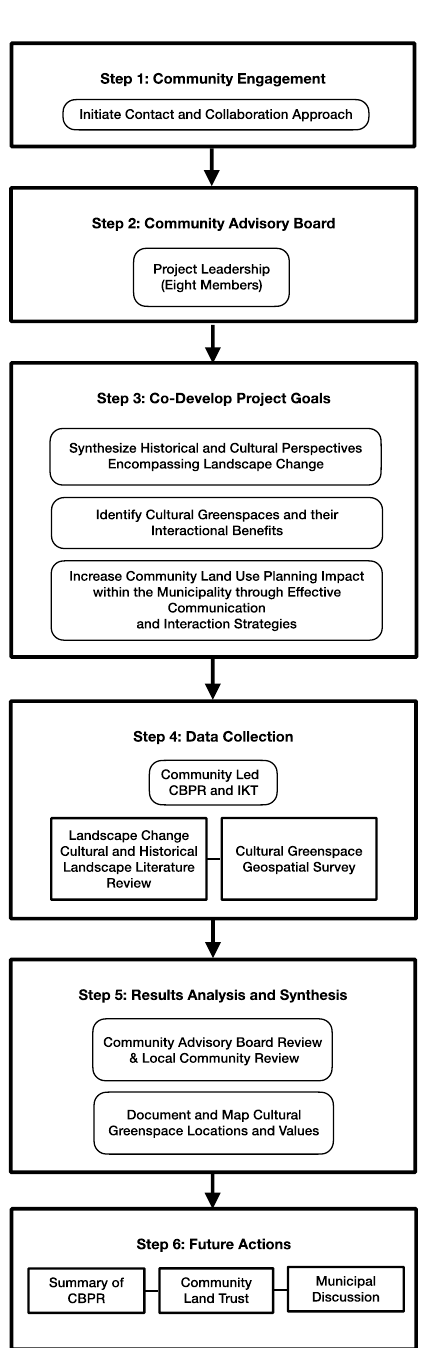
Figure 1. Framework of Study procedure.